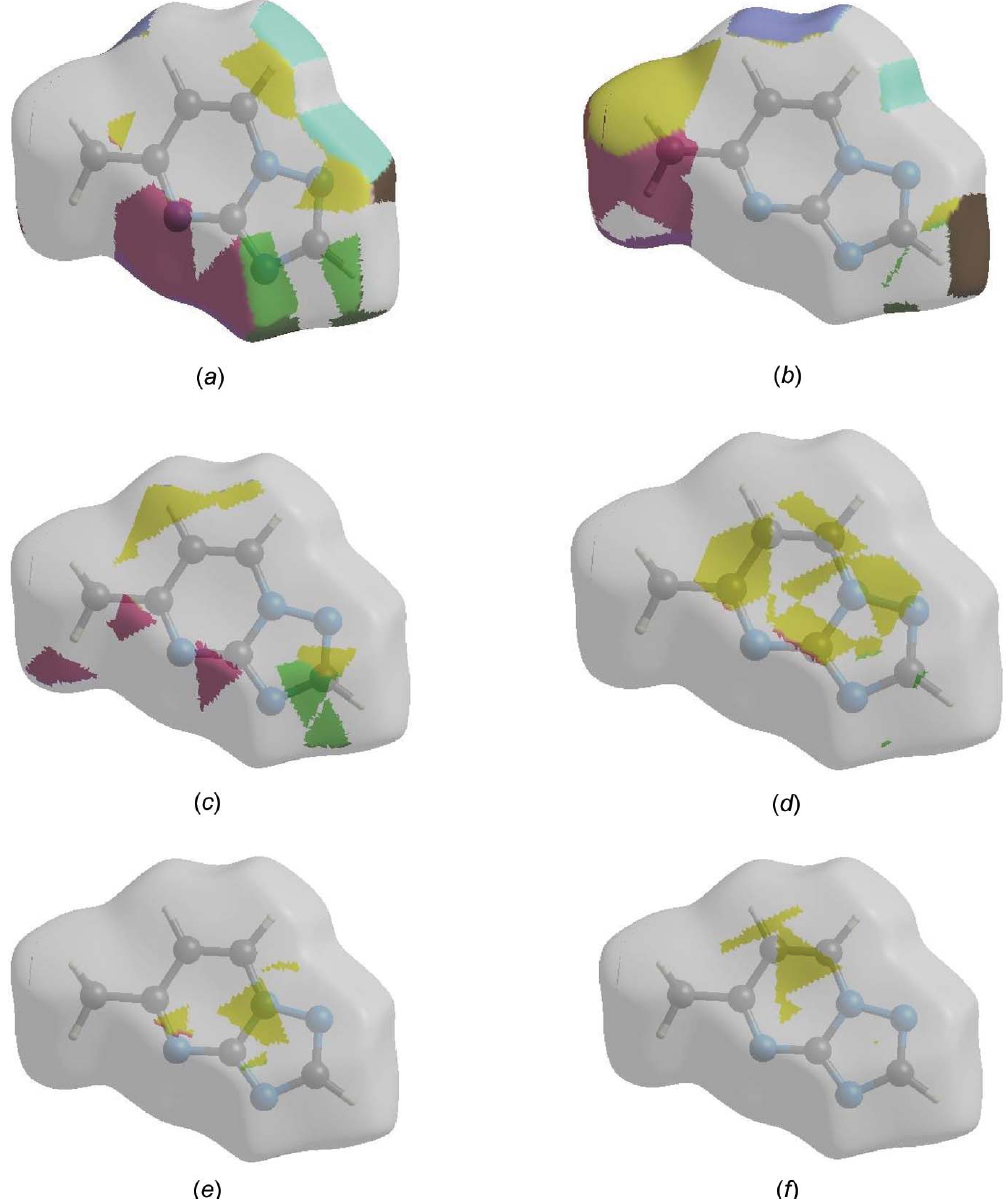
Figure 8 The Hirshfeld surface representations with the function d norm plotted onto the surface for ( a ) H (cid:2)(cid:2)(cid:2) N/N (cid:2)(cid:2)(cid:2) H, ( b ) H (cid:2)(cid:2)(cid:2) H, ( c ) H (cid:2)(cid:2)(cid:2) C/C (cid:2)(cid:2)(cid:2) H, ( d ) N (cid:2)(cid:2)(cid:2) C/ C (cid:2)(cid:2)(cid:2) N, ( e ) N (cid:2)(cid:2)(cid:2) N and ( f ) C (cid:2)(cid:2)(cid:2) C Fig. 7( c ), arise from the short interatomic H (cid:2) (cid:2) (cid:2) H contacts, which make a 35.3% contribution to the HS and are seen as widely scattered points of high density arising from the large hydrogen content of the molecule. In the absence of C—H (cid:2) (cid:2) (cid:2) (cid:2) interactions, the pair of wings in the fingerprint plot delineated into H (cid:2) (cid:2) (cid:2) C/C (cid:2) (cid:2) (cid:2) H contacts (9.5% contribution to the HS) have a nearly symmetrical distribution of points, Fig. 7( d ), with (cid:6) 2.77 A˚ . The N (cid:2) (cid:2) (cid:2) C/C (cid:2) (cid:2) (cid:2) N [Fig. 7( e )] and the tips at d + d e i N (cid:2) (cid:2) (cid:2) N [Fig. 7( f )] contacts make contributions of 9.0 and 3.1%, respectively, to the HS and have widely scattered distributions of points. Finally, the C (cid:2) (cid:2) (cid:2) C [Fig. 7( g )] contacts (3.0%